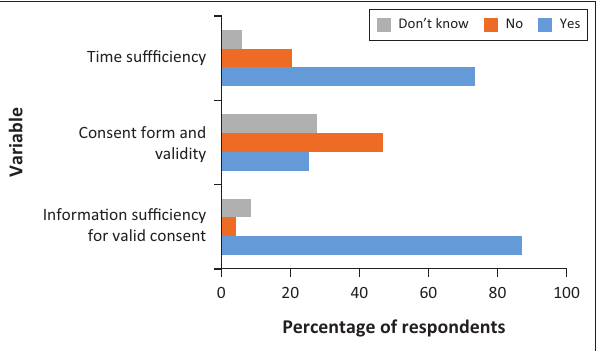
FIGURE 2: Time sufficiency, information and consent forms used to obtain valid informed consent.